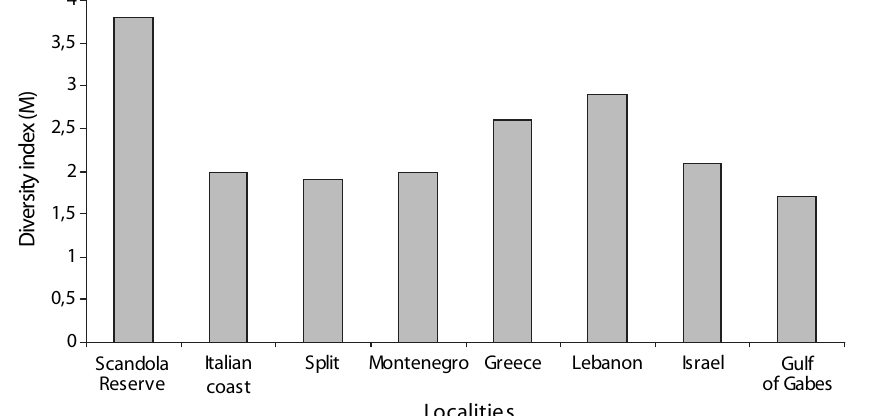
Fig. 2. – Digenean species diversity in the Gulf of Gabes and other areas of the Mediterranean. Scandola Reserve (Bartoli et al. , 2005), North- western Italian coast (Orecchia & Paggi 1978), Split (Sey, 1970), Mon- tenegro (Radujkovi Č et al. , 1989), Greece (Papoutsoglou, 1976), Lebanon (Saad-Fares, 1980), Israel (Fischthal, 1980), Gulf of Gabes (present